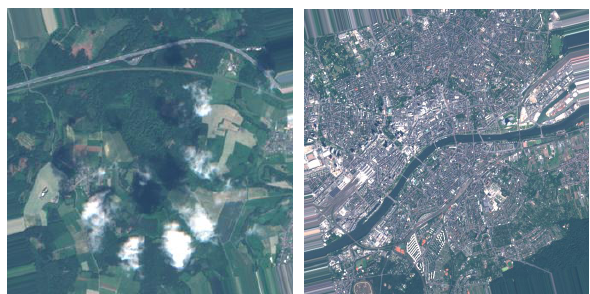
Figure 7. Left: Test area Fch with scattered clouds north of Frankfurt, 3 × 3 km 2 , right: Test area Ffm over the city of Frankfurt am Main, 5 × 5 km 2